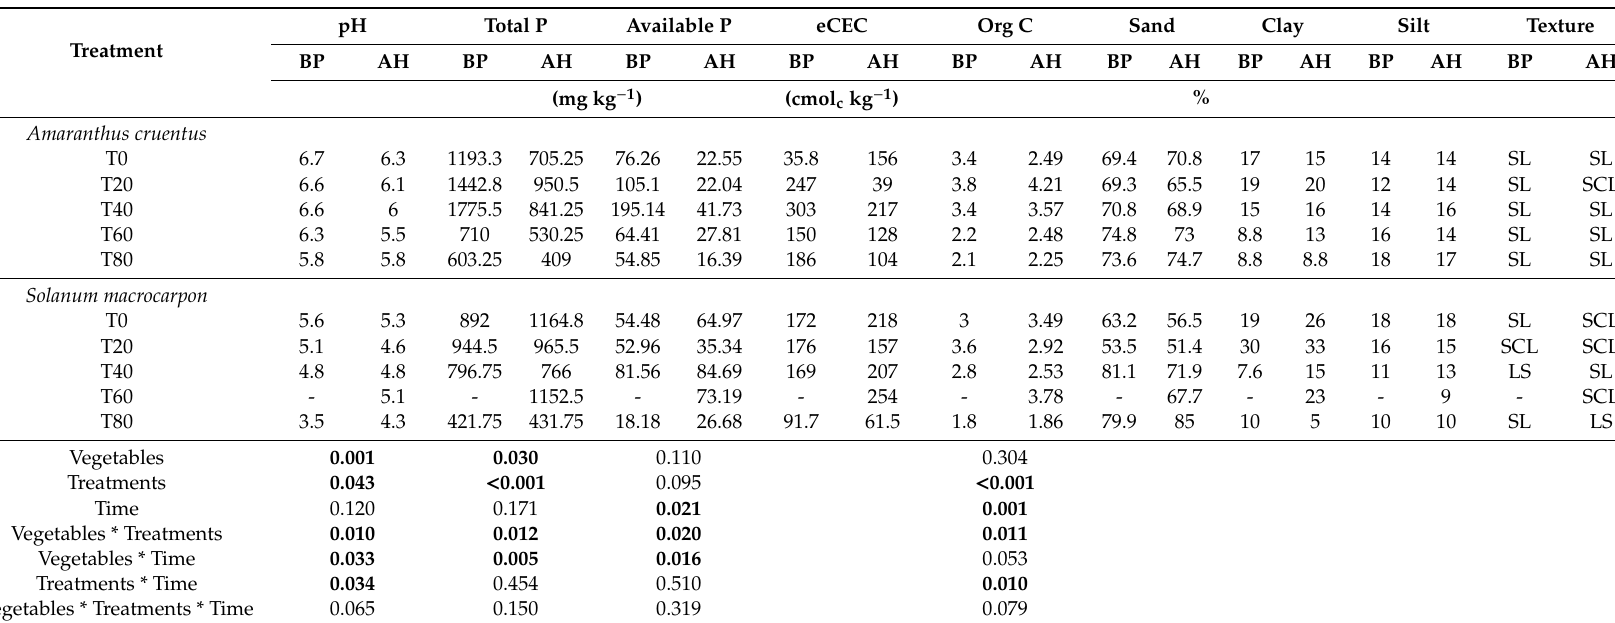
Table 2. Physico-chemical properties of the Ilesha (rainforest) soils cultivated with Amaranthus cruentus and Solanum macrocarpon ( n = 4). pH Total P Available P Treatment